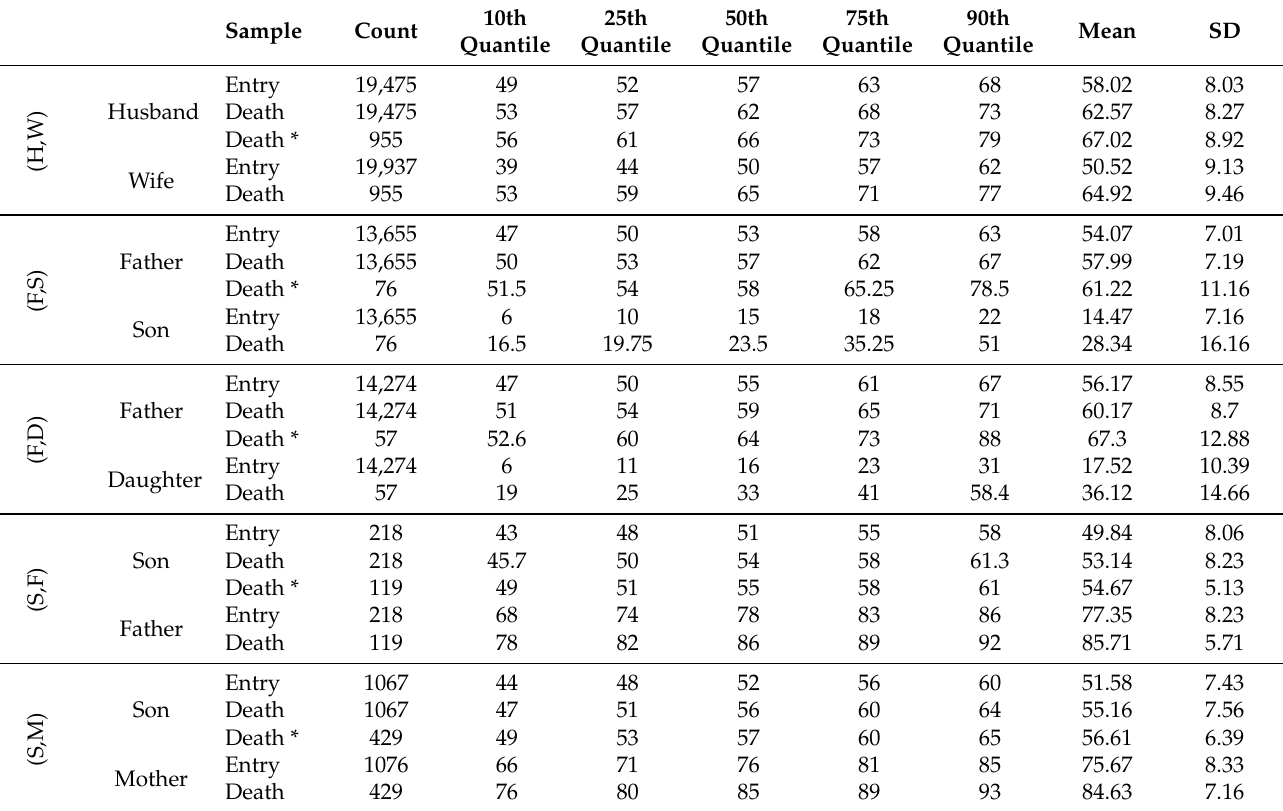
Table 2. Descriptive statistics for age at entry (Entry) and age at death (Death) for each of the five samples. “Death *” gives the descriptive statistics for policyholders whose beneficiaries have also